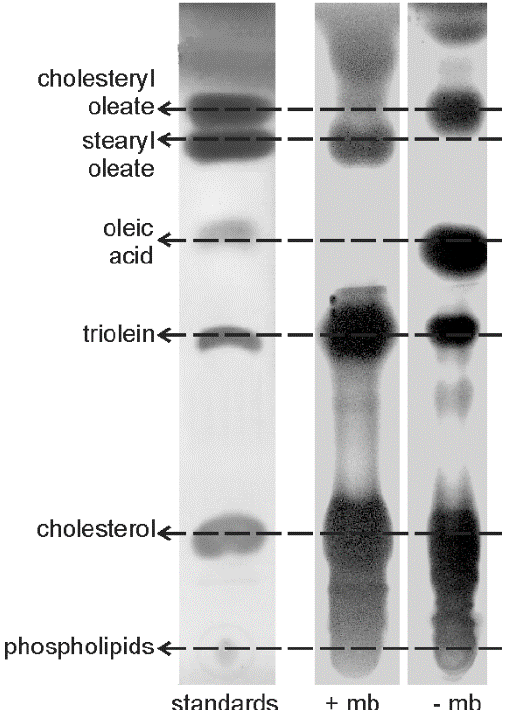
Figure 8. Thin layer chromatography profiles of lipid standards, and of the lipid extracts of the prismatic layer of Pinna , with (+mb) and without ( − mb) the inter-prismatic membrane.